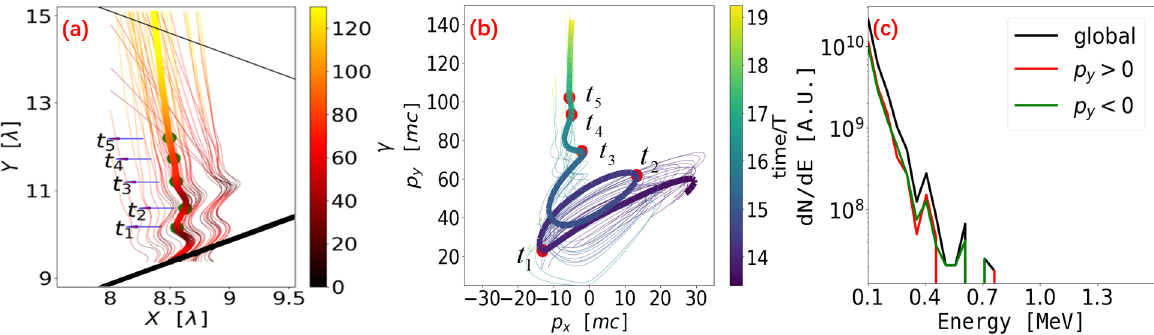
Figure 5. (Color online). ( a ) The electron trajectories after leaving the target surface. ( b ) The variation in electron momentum p x over time. ( c ) The energy spectrum of photons; the cut-off energy is less than 1 MeV. ( a – c ) are all in the planar target case. The values of t 1 , t 2 , t 3 , t 4 and t 5 are the same as those in the cone target case.